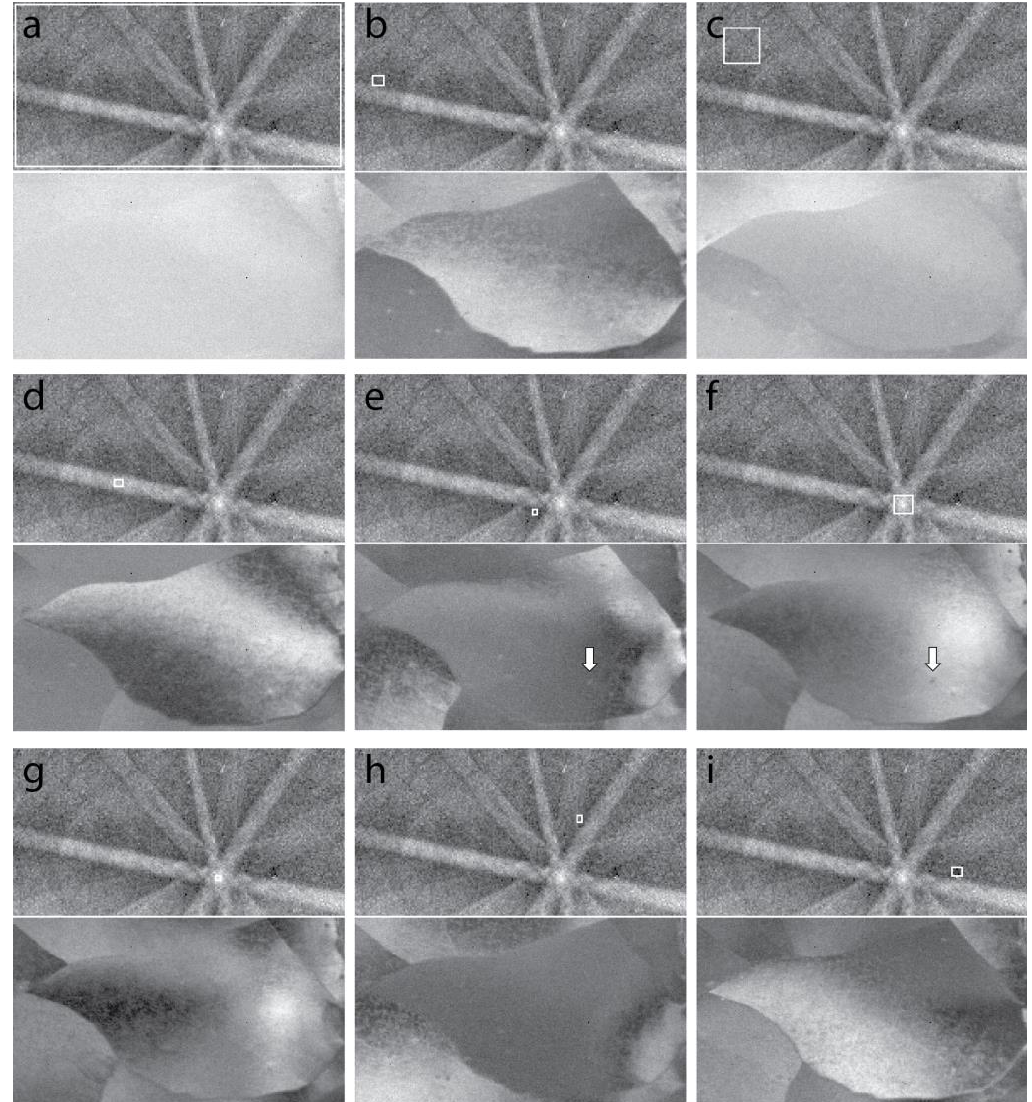
Figure 11. ( a – i ) EBSD-DF images obtained after collecting the intensities from the pixel arrays (virtual beam) defined by the white squares in the reference Kikuchi pattern (t-EBSP). The top and bottom images correspond to the reference pattern and the EBSD-DF image. The white arrows indicate the precipitates affected by the diffraction condition used (see text for more information). Note that the t-EBSPs were background subtracted to enhance diffraction contrast. The scalebar displayed on the STEM image in Figure 9a applies to all reconstructed images this figure.